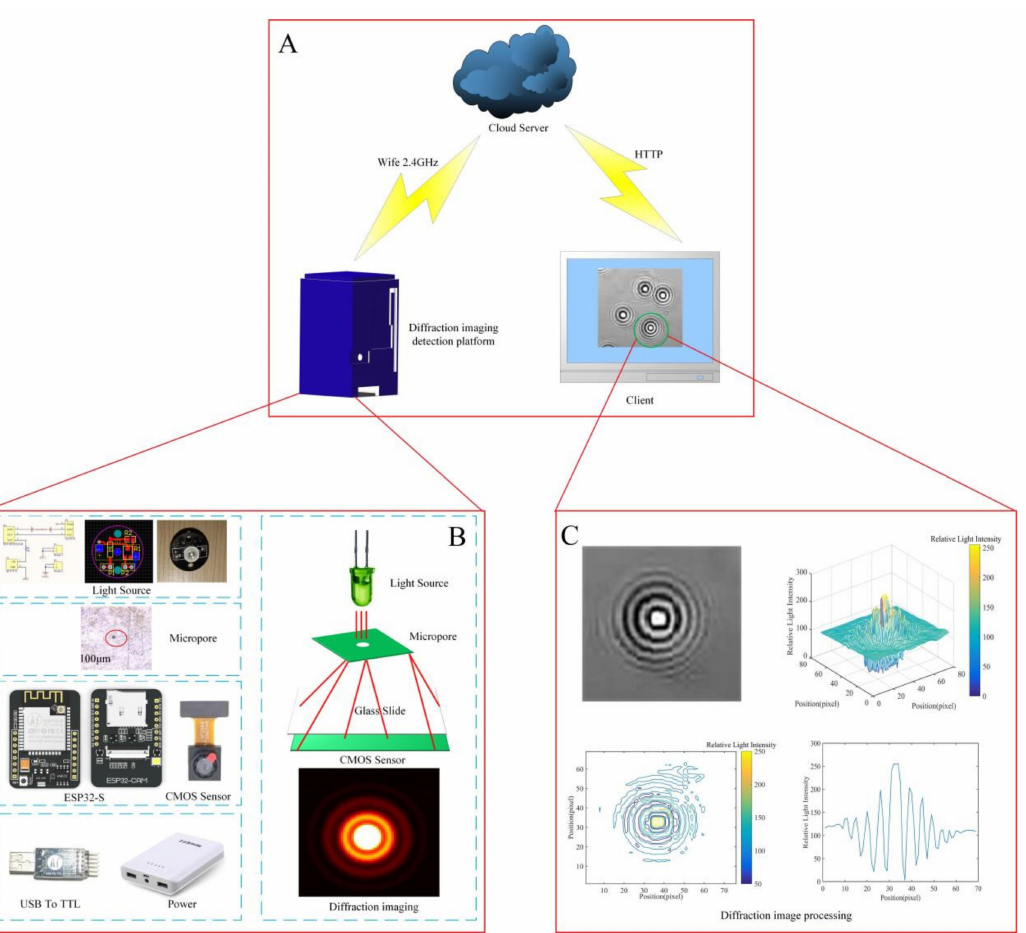
Figure 2. The fungal spores diffraction fingerprint collection system, ( A ) diffraction fingerprint collection system architecture, ( B ) diffraction fingerprint image detection platform, and ( C ) diffraction fingerprint image